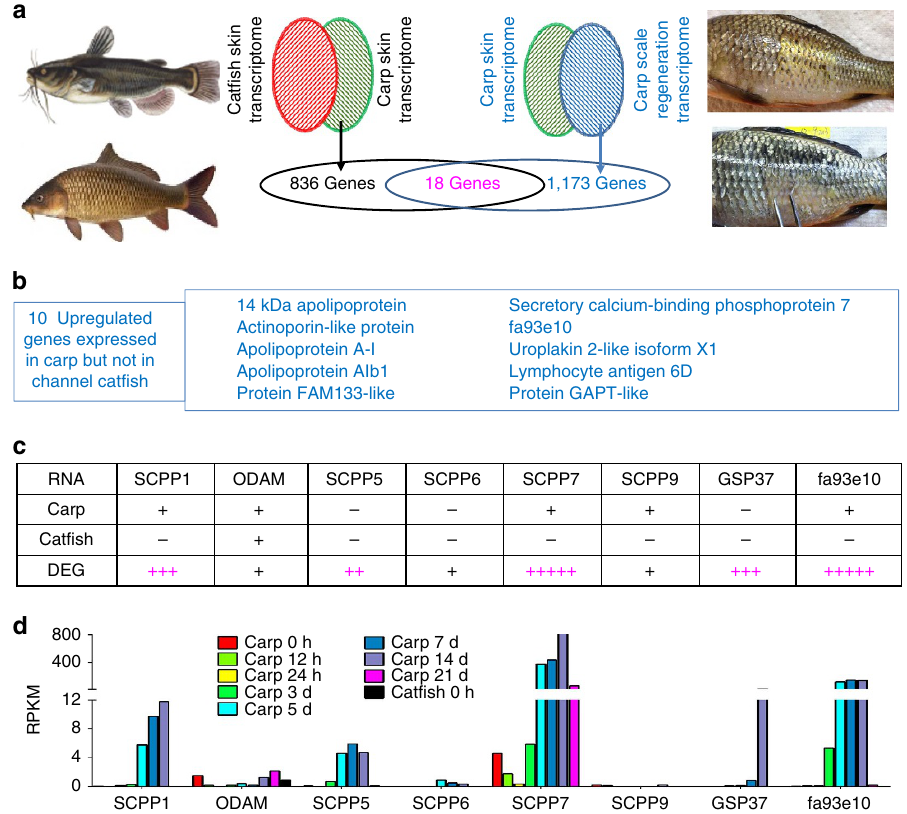
Figure 5 | Comparative subtraction analysis of transcriptomes. ( a ) Interspecific comparative transcriptome analysis: the channel catfish skin transcriptome and the carp skin transcriptome was comparatively subtracted, leading to the identification of 836 genes expressed only in the carp skin but not in the channel catfish skin (left); similarly, the carp skin transcriptomes before scale regeneration and during scale regeneration were comparatively subtracted, leading to the identification of 1,173 differentially expressed genes during scale regeneration. The pool of the 836 genes and 1,173 genes shared (intersection) a total of 18 genes including 13 known genes and five uncharacterized genes. ( b ) A list of the 10 upregulated genes identified from the shared intersection of the genes expressed in carp but not in channel catfish skin and those differentially expressed during scale regeneration. ( c ) A summary of SCPP expression in the carp skin (Carp), catfish skin (Catfish) and during scale regeneration (DEG). Plus ( þ ) indicates expression and minus ( (cid:2) ) indicates no expression. Multiple pluses indicate degree of induced expression, and purple colour indicated that they were significantly upregulated. ( d ) SCPP expression during the course of scale regeneration, with their expression levels expressed as reads per kilobase of exon per million mapped reads (RPKM) on the y axis, genes indicated on the x axis, and time points expressed in bars of different